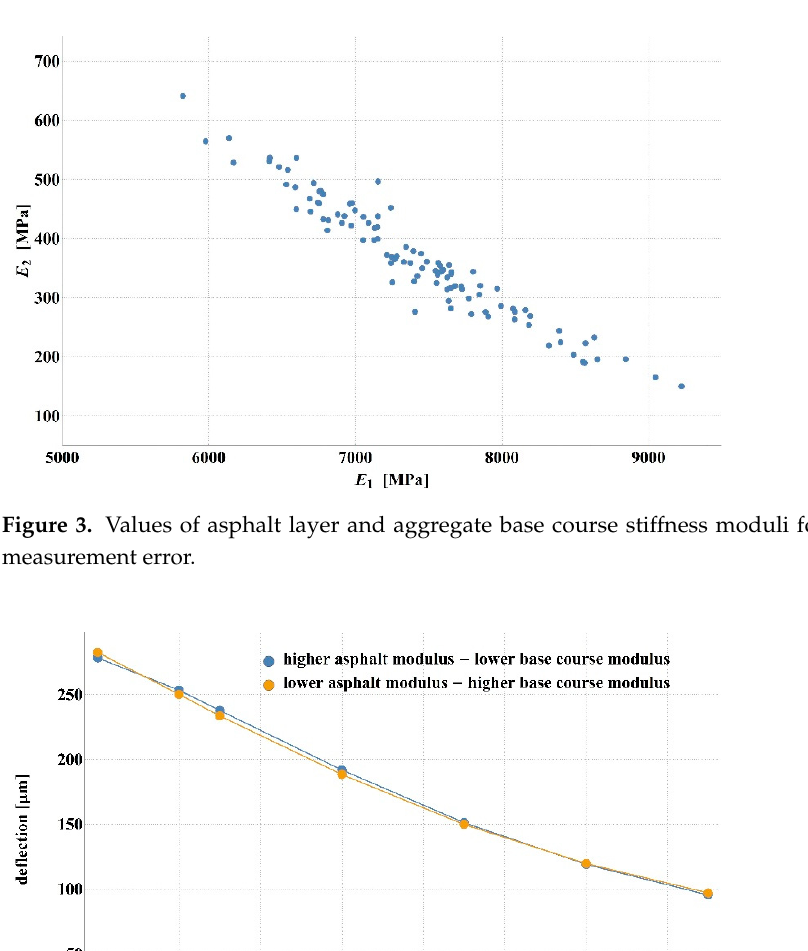
Figure 5. Ratio of displacement for the case with higher asphalt layer modulus—lower aggregate base course modulus to lower asphalt layer modulus—higher aggregate base course modulus. In the case of D2S variant of the measurement error—simulating a systematic error, analogous for all measurement points—the dispersion of values was smaller, and for larger values of the asphalt layer modulus, a larger aggregate base course modulus was obtained. This is illustrated in Figure 6